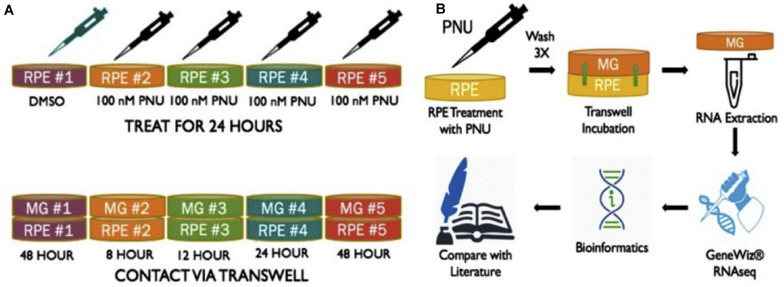
Schematic of methods performed to obtain RNA from Müller glia exposed to PNU-282987 treated RPE cells. (A) (1) RPE-J treated for 24 h with DMSO as a vehicle control. (2-5) RPE-J cells treated for 24 h with PNU-282987. PNU-282987 was removed and thoroughly washed away with PBS before being replace with normal media. (B) After PNU-282987 treatment and thorough rinsing, RPE were exposed to rMC-1 cells via transwells and allowed to incubate for 8, 12, 24, and 48 h. RNA was extracted from Müller glia and sent to GeneWiz for RNA sequencing. Some bioinformatics was performed to determine log2 fold changes of identified RNA sequences compared to DMSO controls.